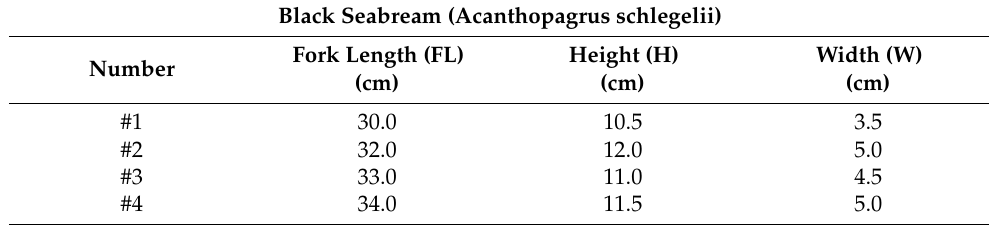
Table 1. Fork length ( FL ), height ( H ), and width ( W ) of the experimental Black seabream ( Acanthopa- grus schlegelii